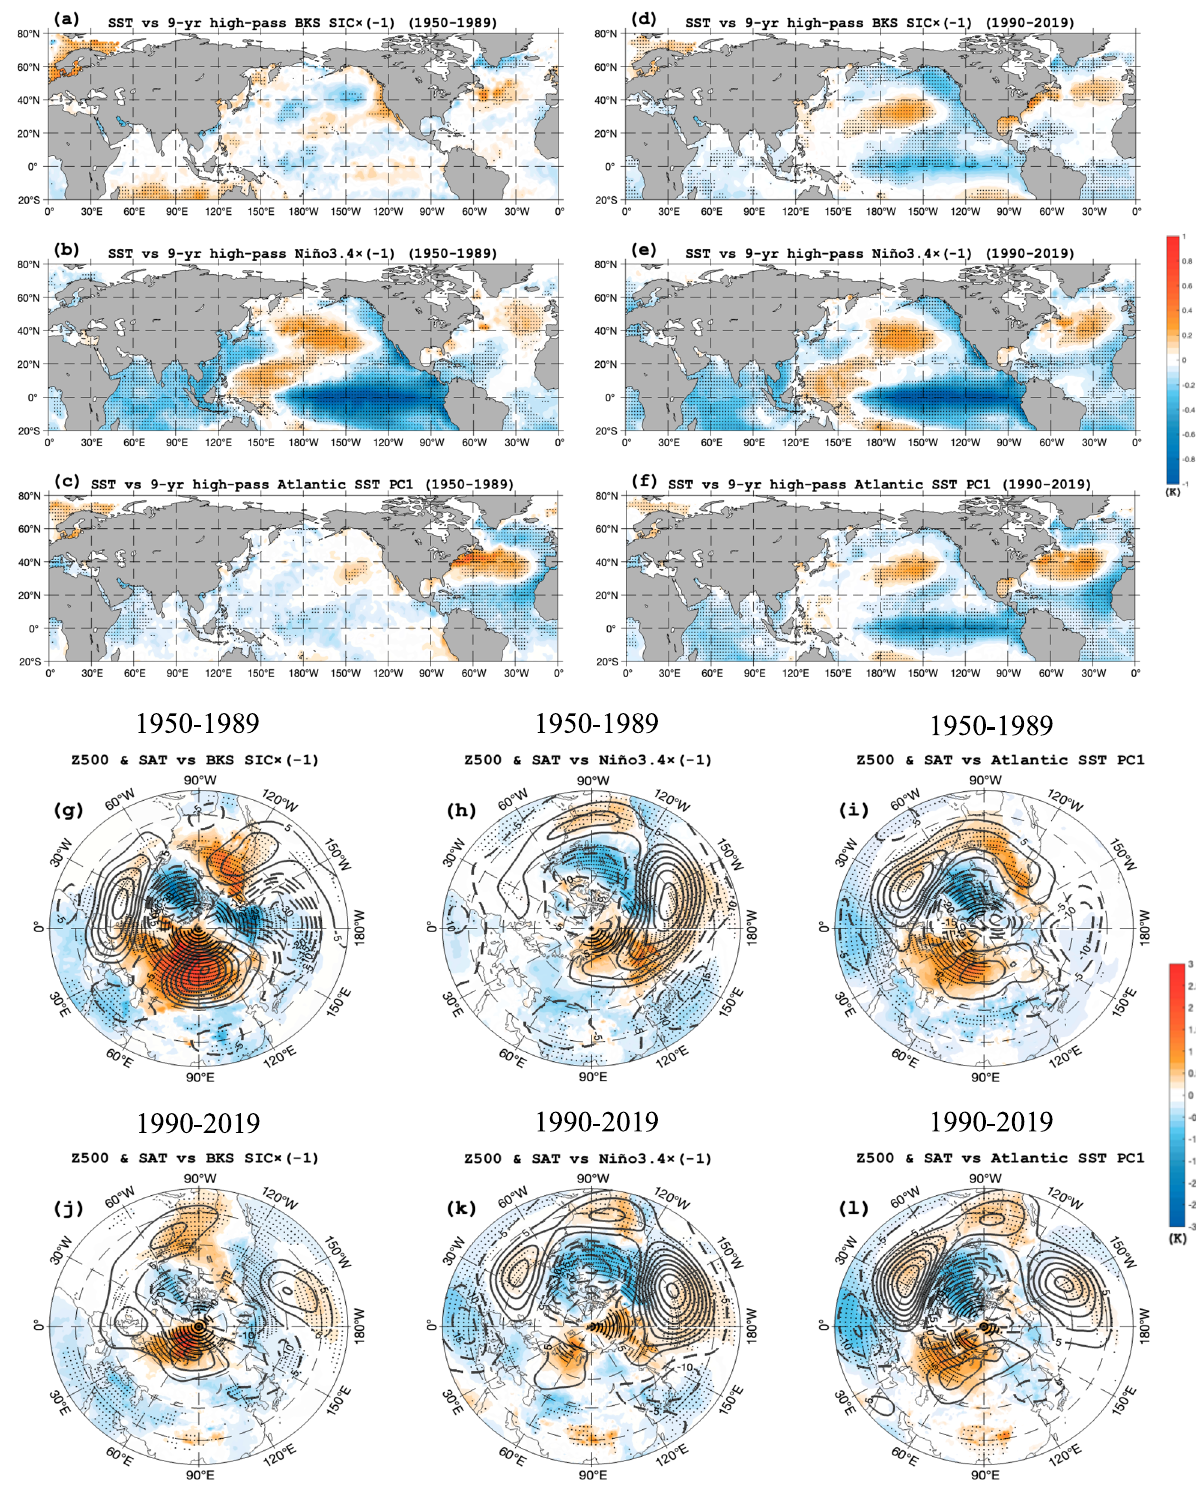
Fig. 3 | Spatial patterns of winter sea surface temperature (SST), 500-hPa geopotential height (Z500) and surface air temperature (SAT) anomalies related to the interannual variations of the sea ice concentration (SIC) over Barents-Kara Seas (BKS), North Atlantic SST and Niño3.4 index. a – l Regressed DJF(December-February)mean a – f SSTand g – l Z500(contourinterval=10,gpm)